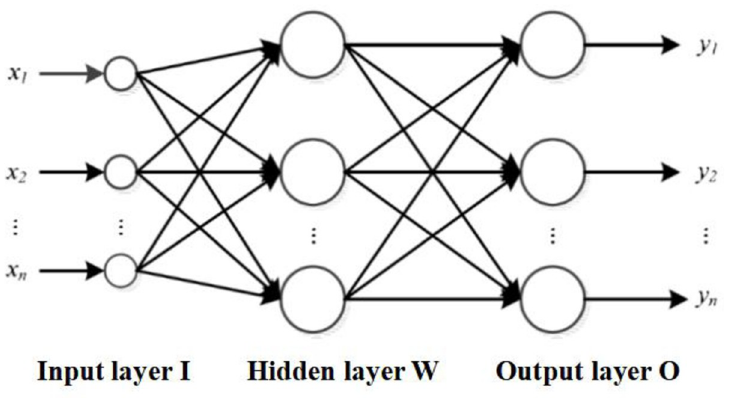
Fig 1. BP neural network model